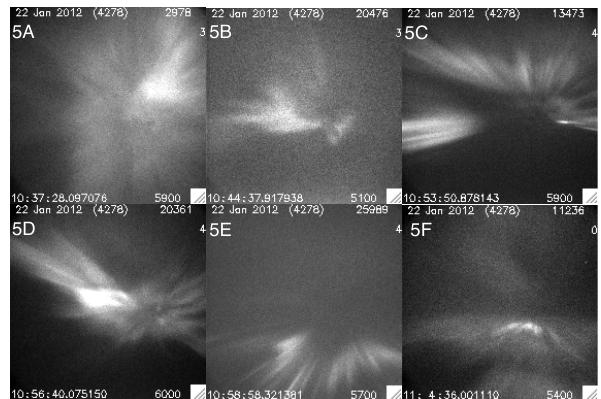
Figure 19. Event 5: narrow-field images (15 ◦ FOV) – taken on 22 January 2012 with a 427.8nm filter – showing the small-scale structure of the aurora at the times of the NEIALs in the PFISR data (labeled 5A–5CF). The magnetic zenith – the location of the radar beam ( ∼ 1 ◦ beamwidth) – is located near the center of each image. Same orientation as Fig.